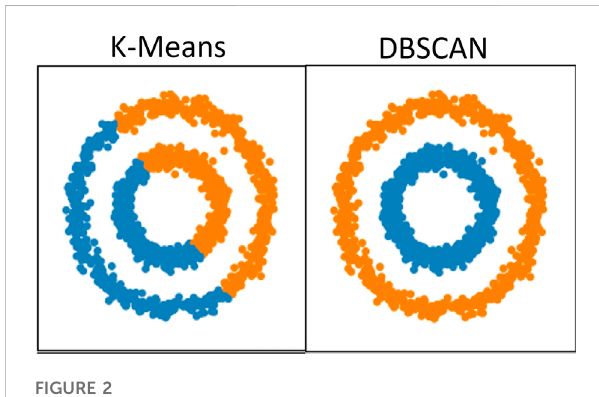
FIGURE 2 Comparison between K-means (distance-based) and DBSCAN (density-based). Reproduced from Comparing different clustering algorithms on toy datasets